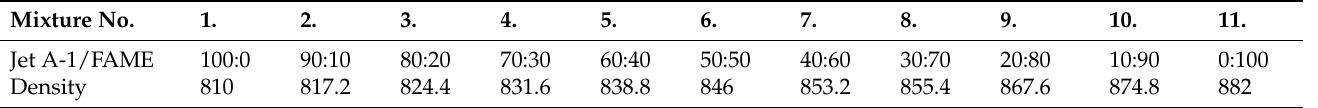
Table 5. Composition of the mixture of aviation kerosene Jet A-1 and